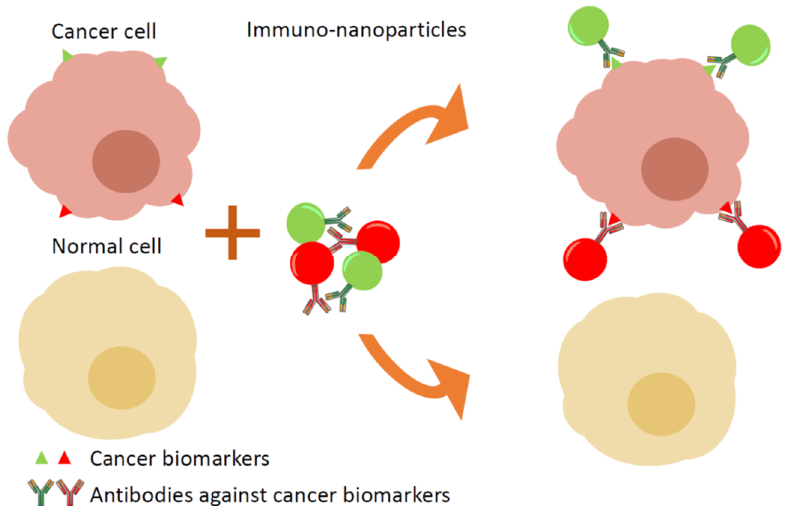
Figure 4. Targeting of cancer cells in tissue samples: multiple immuno-nanoparticles with specific antigens against cancer biomarkers label cancer cells. Each antibody is conjugated with different coloured luminescent nanoparticles, which allows the simultaneous detection of several biomarkers in one sample.